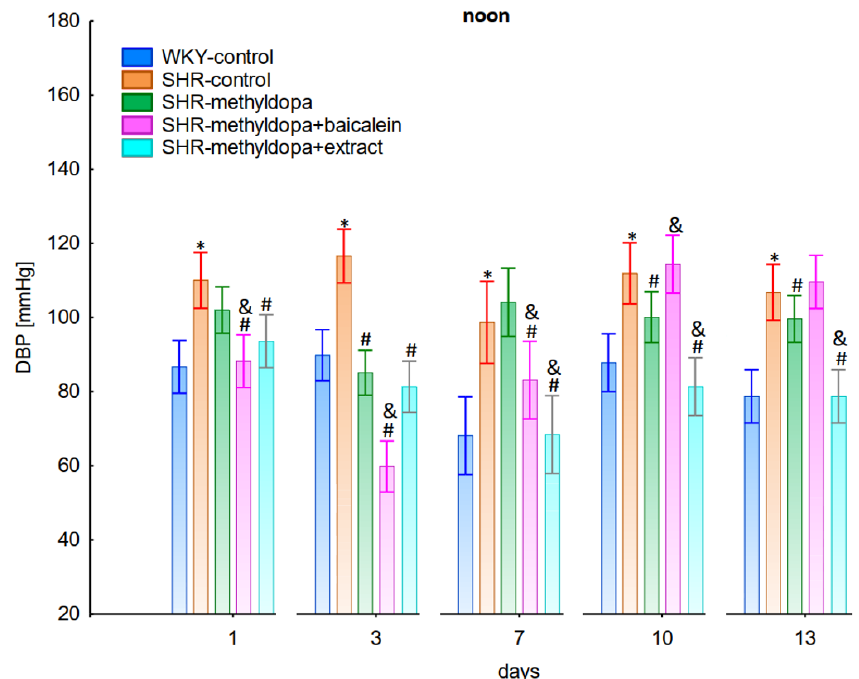
Figure 5. Influence of methyldopa and its combination with baicalein or extract from Scutellaria baicalensis roots on noon diastolic blood pressure (DBP) in SHR pregnant rats. Legend: n = 10, mean ± SEM; *—vs. WKY control, p < 0.05; #—vs. SHR control, p < 0.05; &—vs. SHR-methyldopa, p < 0.05.